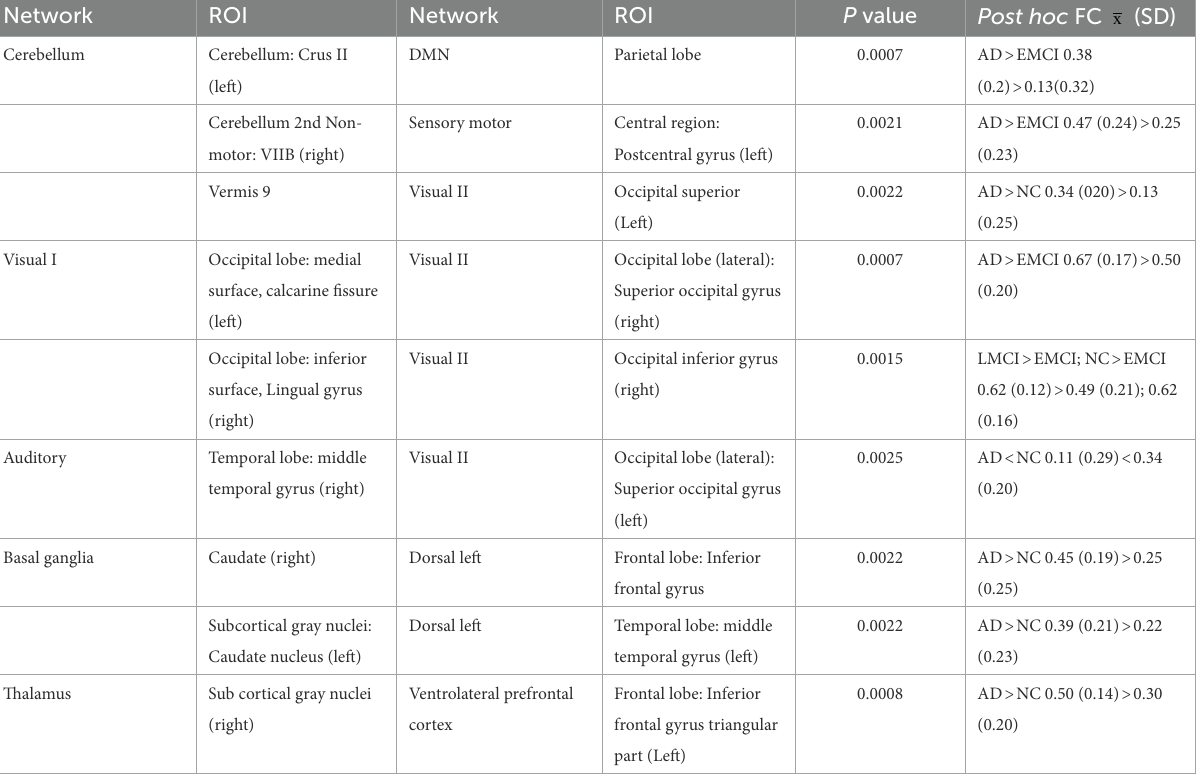
TABLE 2 Pairs of brain regions showing significant differences in FC between groups when performing a one-way ANOVA.